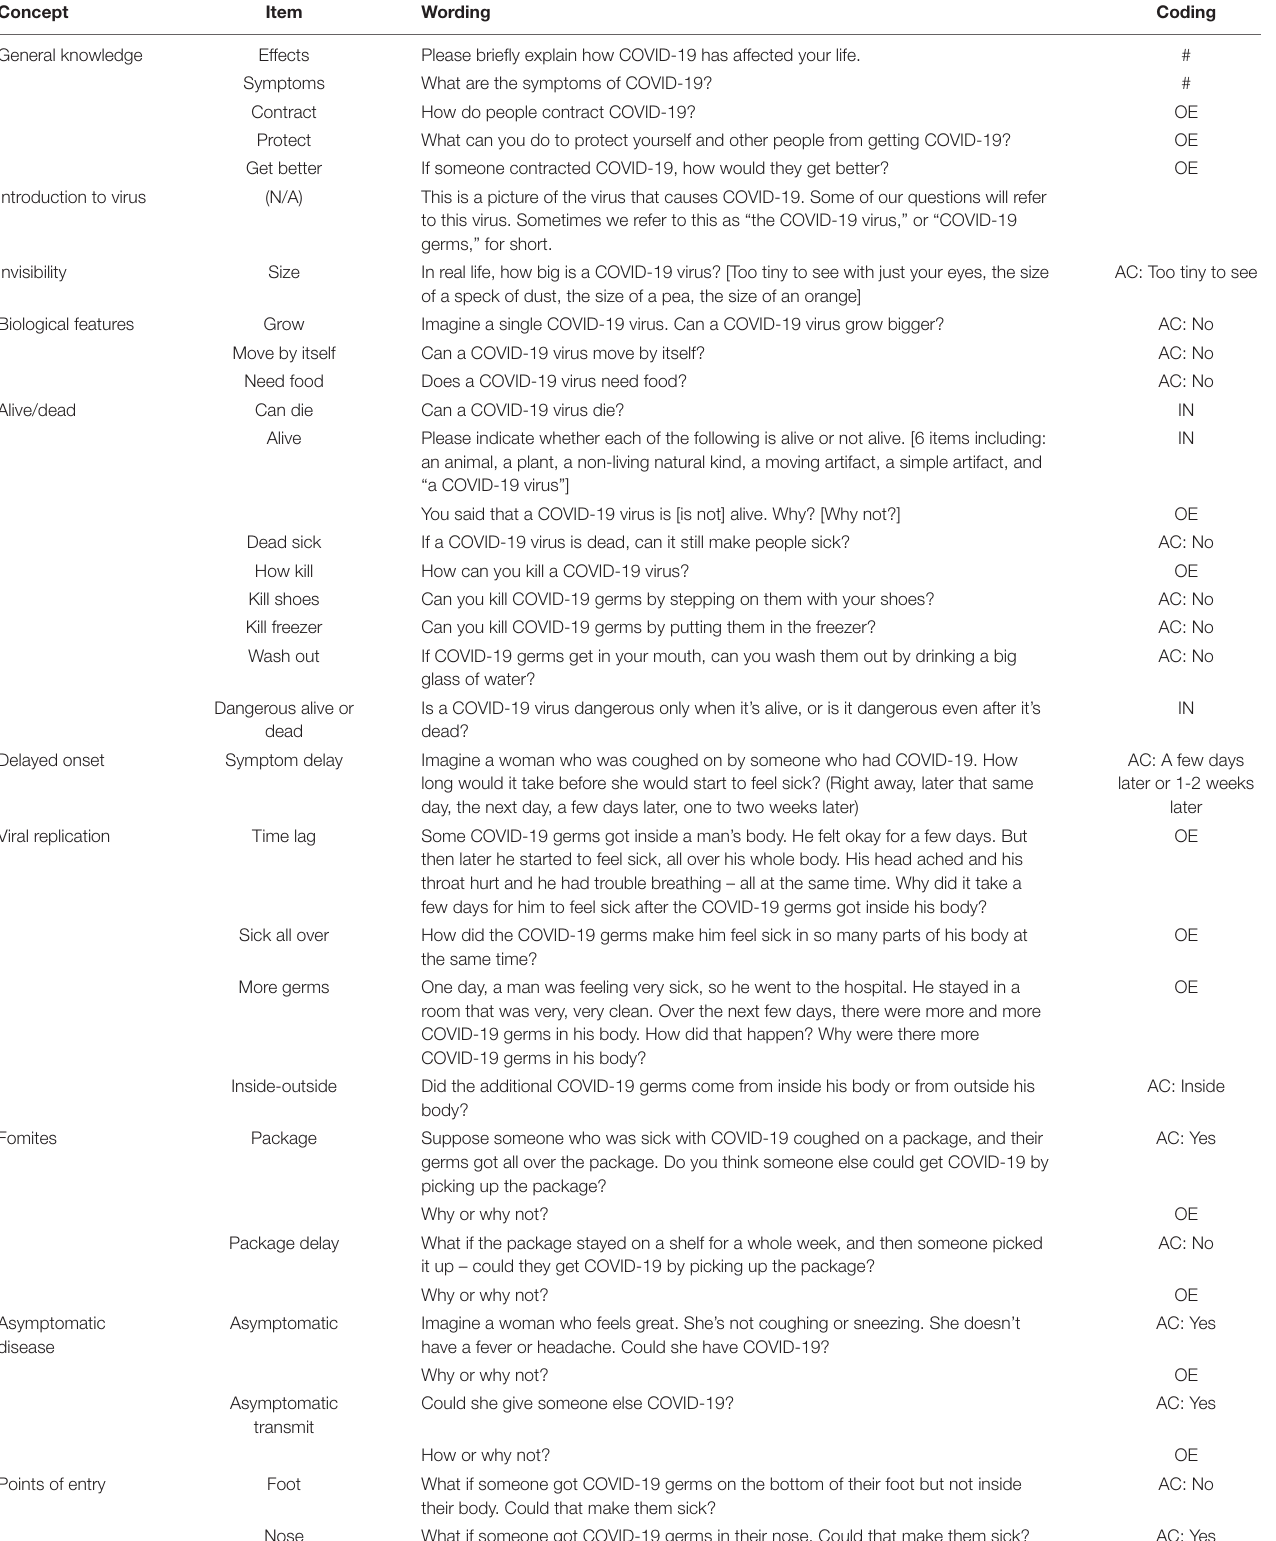
TABLE 1 | Viral transmission survey (COVID-19 version), with concepts and items in order of presentation. Concept Item Wording Coding General knowledge